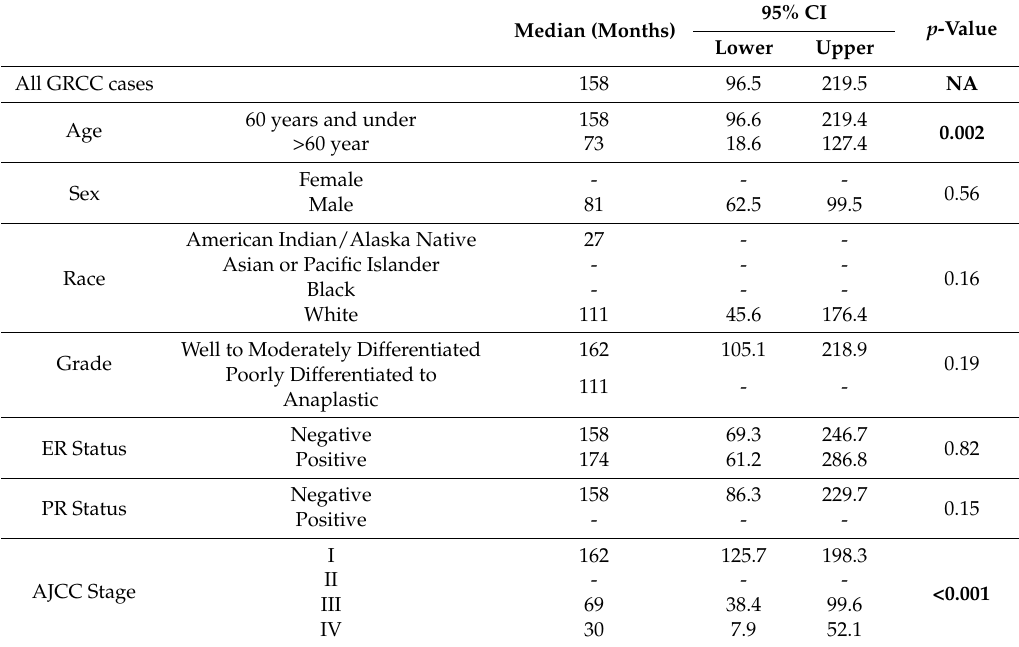
Table 2. Survival durations for glycogen-rich clear cell (GRCC) carcinoma patients. 191